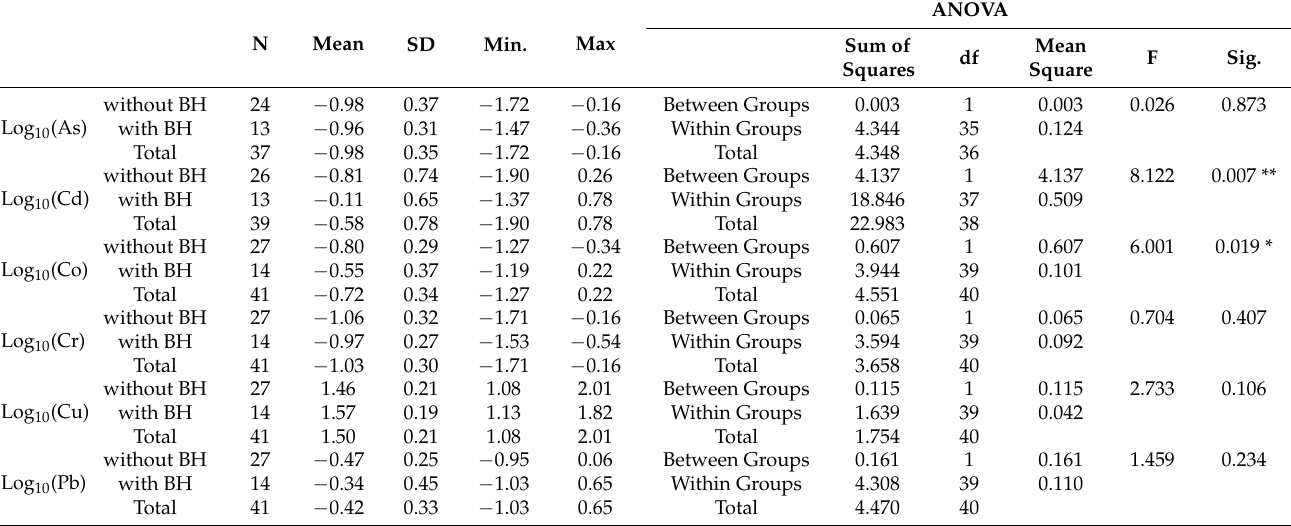
Table 2. ANOVA test summary results for log-transformed (Log 10 (x)) metal(loid)s’